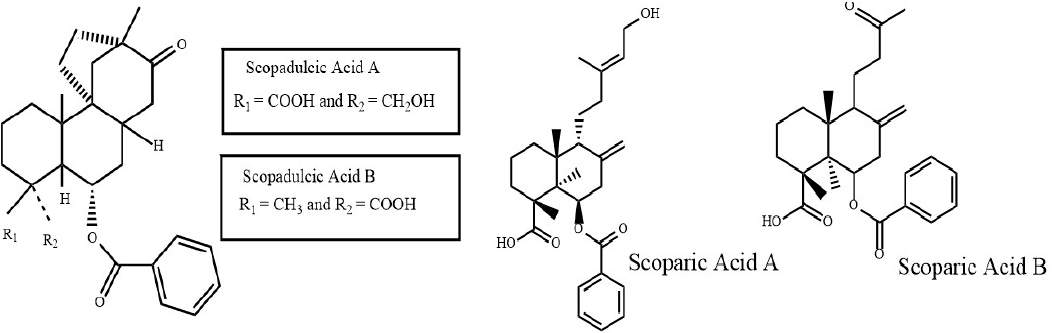
Figure 3. Polyphenols found in Scoparia dulcis.